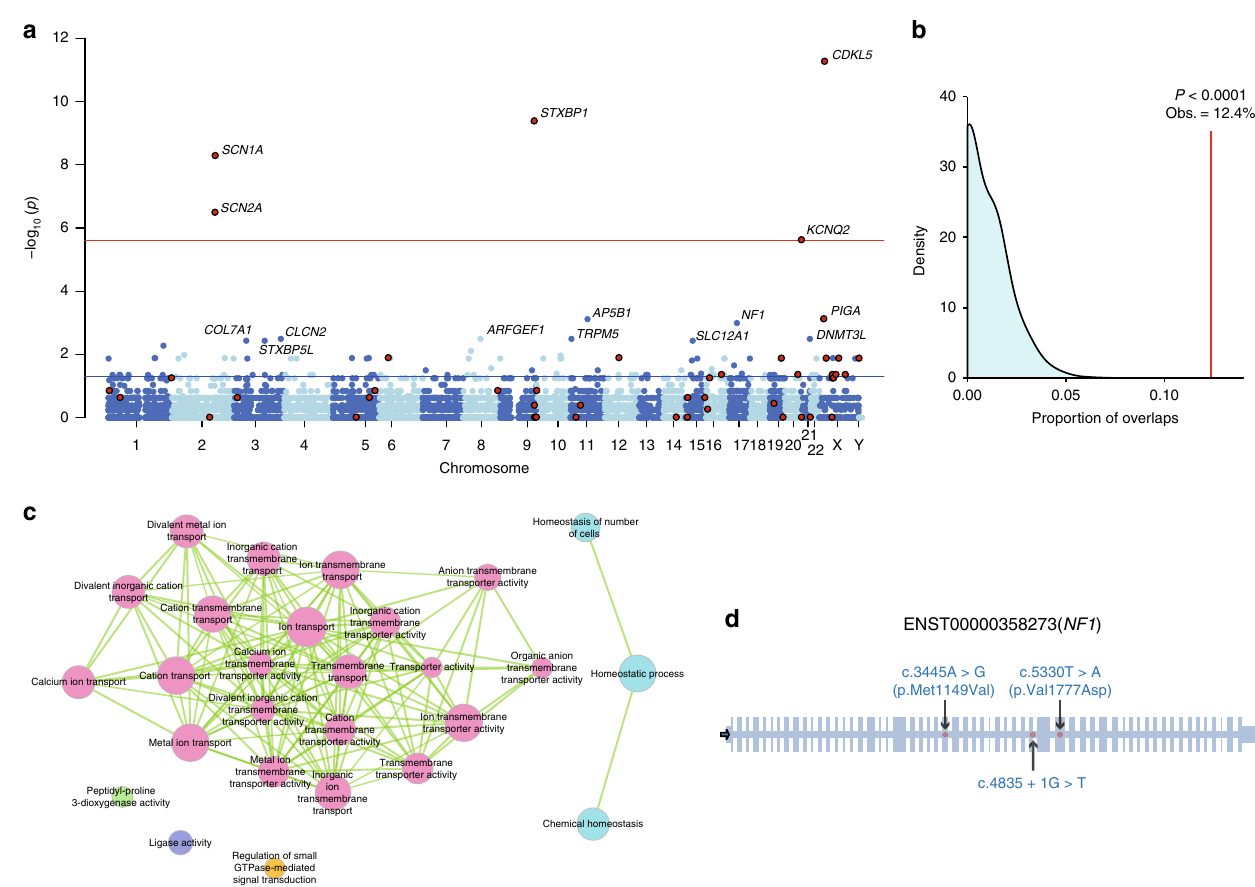
Fig. 3 Gene-based burden test of dURVs. a Manhattan plot of P values for each gene obtained from the gene-based burden test. 58EE/DEE genes are indicated by the red- fi lled black circles. The red and blue horizontal lines indicate the thresholds for exome-wide signi fi cance ( P = 2.5 × 10 − 6 ) and the nominal signi fi cance ( P = 0.05), respectively. Genes with P < 0.005 are labeled with their gene symbols. b The observed overlap between genes with nominally signi fi cant (2.5 × 10 − 6 ≤ P < 0.05) dURV burden and 58EE/DEE genes (the red vertical line: 12.4% of the nominally signi fi cant genes overlapped with 58EE/DEE genes), and an expected distribution of overlaps obtained from random shuf fl ing of the case − control labels in our cohort (cyan area). The corresponding P value calculated from 10,000 times of random shuf fl ing is shown above the red vertical line. c Networks of gene ontology terms represents the signi fi cance of enrichment. Edge width represents the overlap coef fi cient. d A schematic representation of the exon − intron